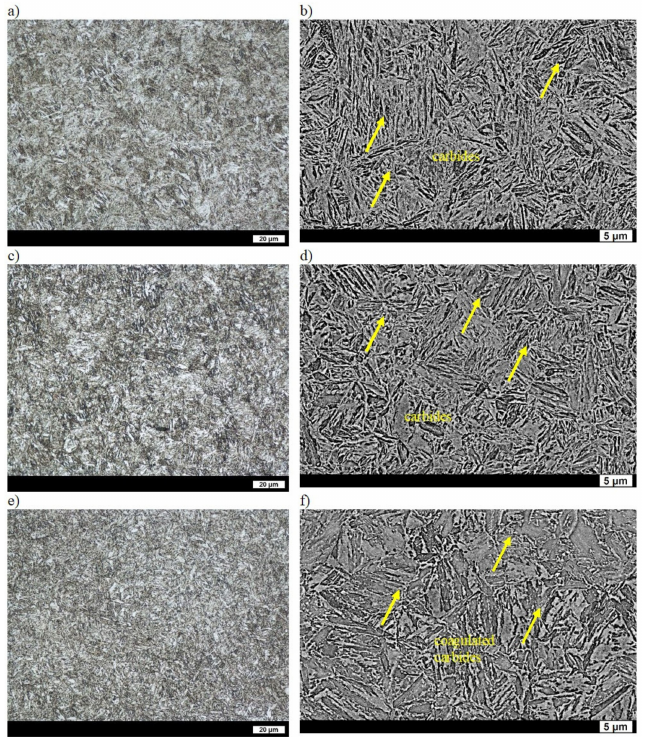
Figure 6. Microstructure of ingot No. 4 after quenching and tempering: ( a ) at 200 ◦ C, LM; ( b ) at 200 ◦ C, SEM; ( c ) at 400 ◦ C, LM; ( d ) at 400 ◦ C, SEM; ( e ) at 600 ◦ C, LM; ( f ) at 600 ◦ C, SEM. Etched with 3% HNO 3